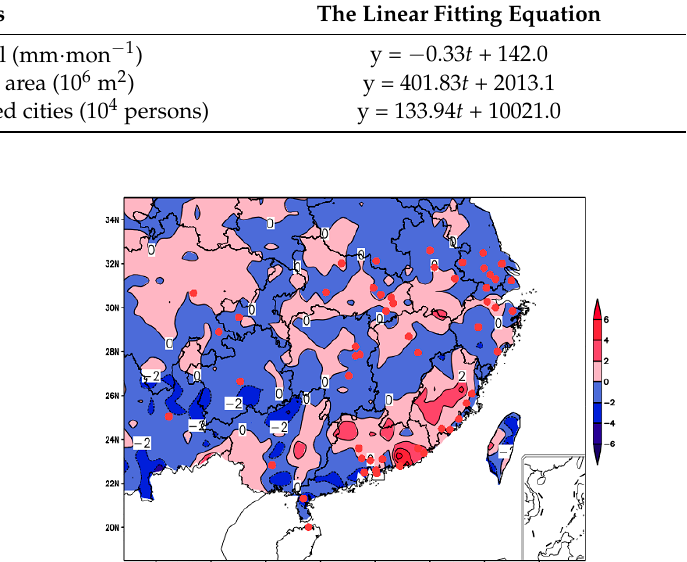
Table 1. Linear regression between the relevant factors and Year. Factors